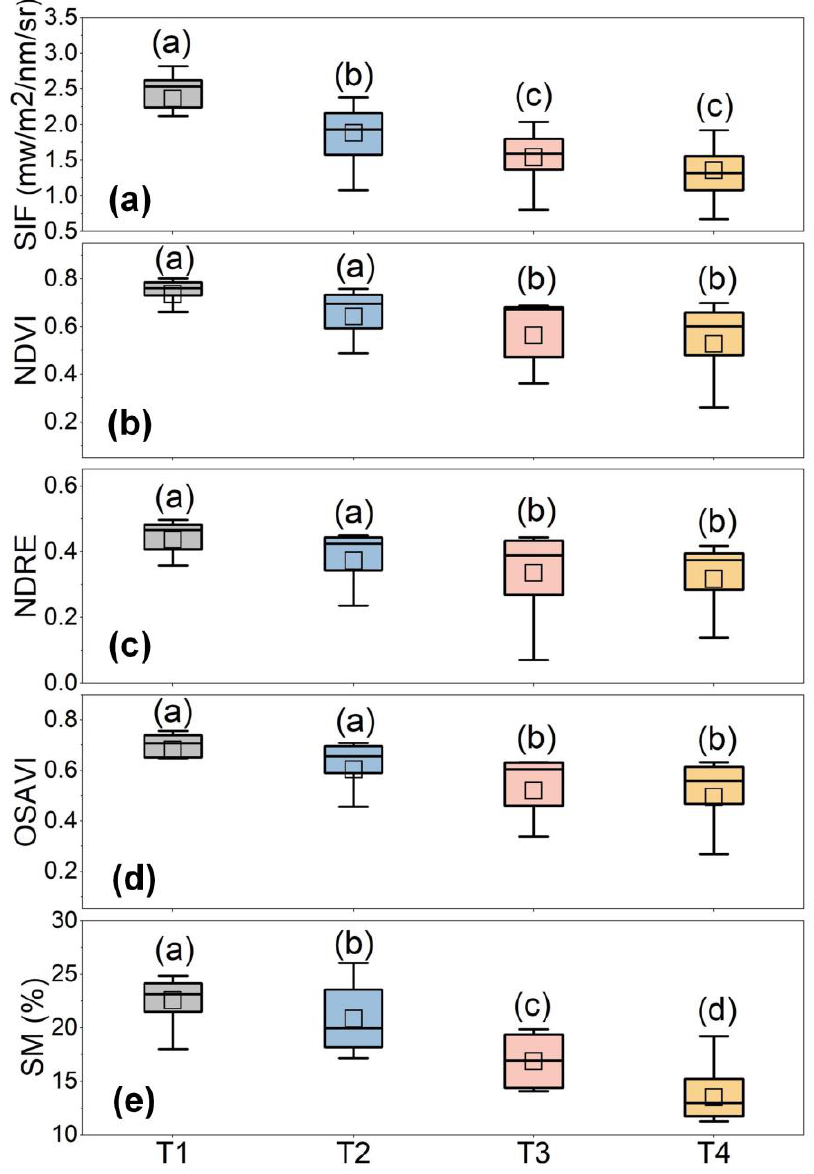
Figure 11. The responds of ( a ) SIF, ( b ) the NDVI, ( c ) NDRE, ( d ) OSAVI and ( e ) SM under different water stresses. Values with different letters indicate significant differences at p < 0.05. The hollow blocks in the figure represent the average values, which were calculated using the data collected from 177 DAP to 223 DAP.